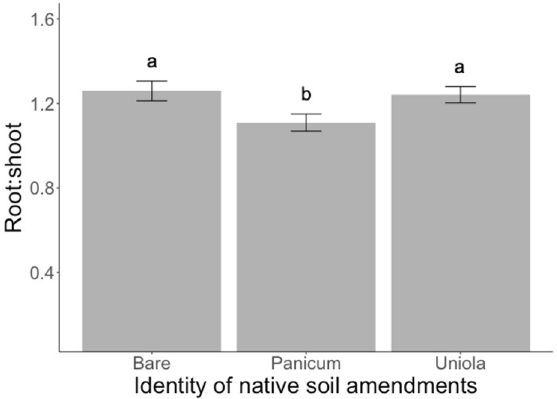
Figure 3. Effect of the identity of native soil amendments on the root:shoot ratio for P. amarum. Bars indicate treatment means ± SE. Letters denote significant differences between native soil amendments estimated using linear models (P < 0.05).